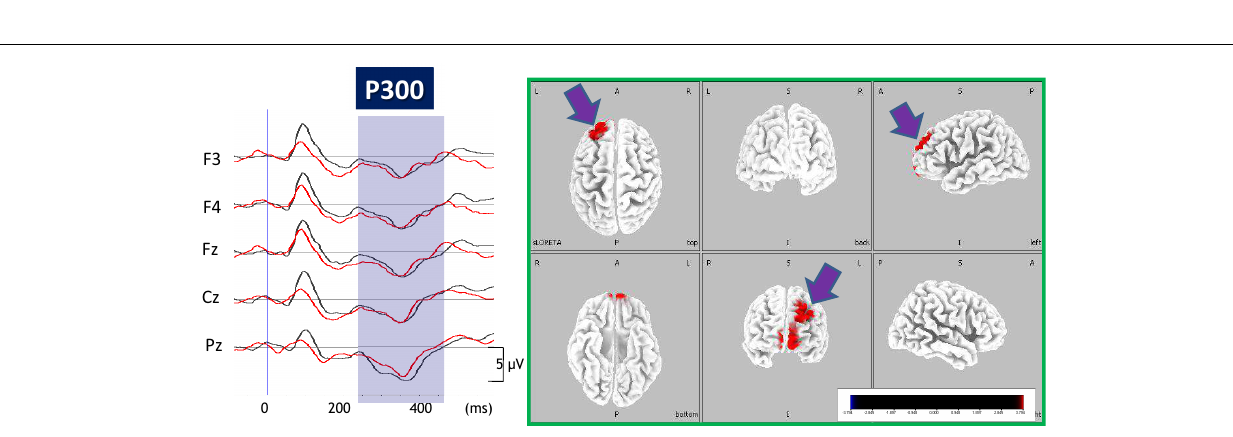
FIGURE 4 | P300 current density change vs. cognition/QOL changes in patients treated with olanzapine .There was a significant positive correlation between improvement of verbal memory and enhancement of